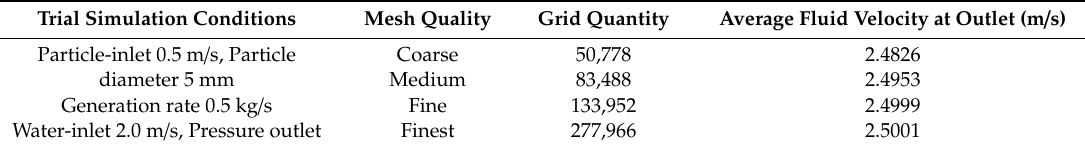
Figure 5. ( a ) The schematic of Y-shaped elbow and ( b ) block-structured grid of the elbow. Table 3. Grid-independence simulation test.